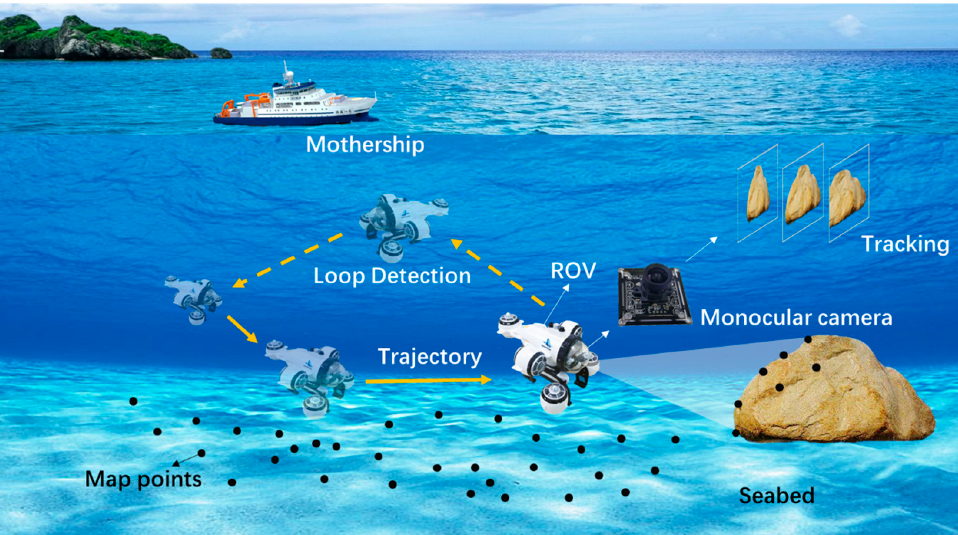
Figure 1. Schematic diagram of underwater visual SLAM.